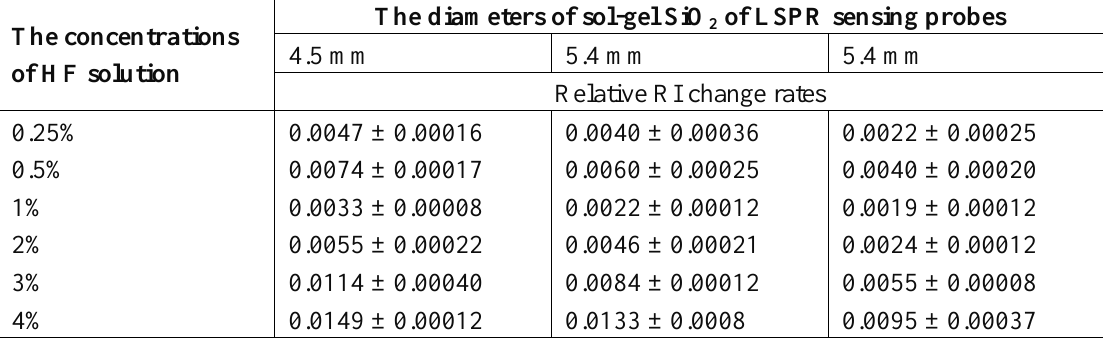
Table 1. Comparisons of Relative RI Change Rates from calculation of the